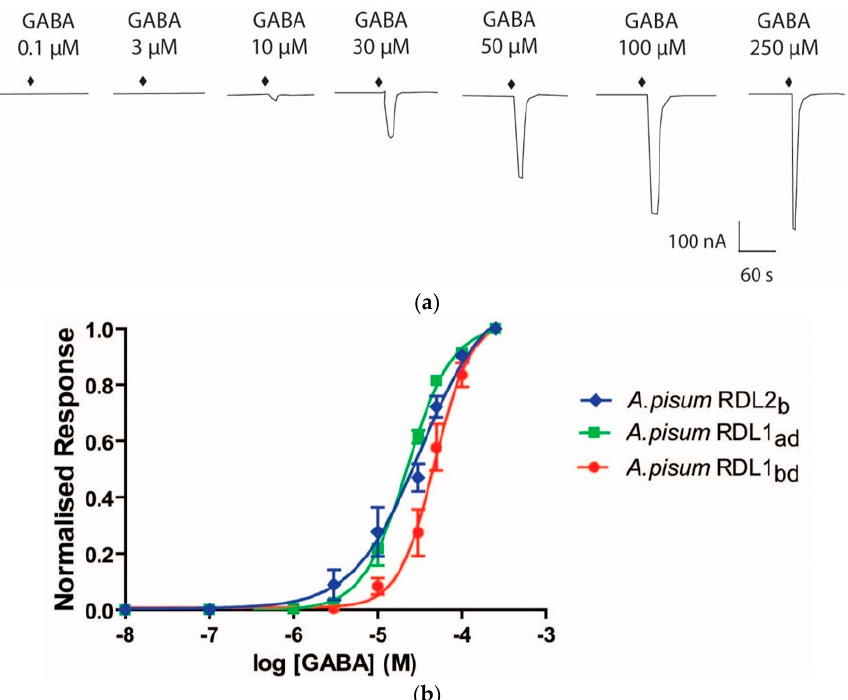
Table 2. Effects of GABA on membrane currents from X. laevis oocytes expressing A. pisum RDL, with maximum amplitude ( I max ), EC 50 and hill coefficient (nH) displayed. The I max was obtained from the initial 250 μ M GABA response measured from eggs clamped at − 60 mV. Also shown are the effects of fipronil and the neonicotinoids imidacloprid (IMI), clothianidin (CLO), and thiacloprid (THI) on GABA EC 50 induced membrane currents. IC 50 values are shown for fipronil, as well as the fraction of response to GABA at EC 50 after exposure to 100 μ M neonicotinoid. All data are the mean ± SEM of 4- 5 oocytes from ≥ 3 different frogs. [–] indicates that this value was not measured.